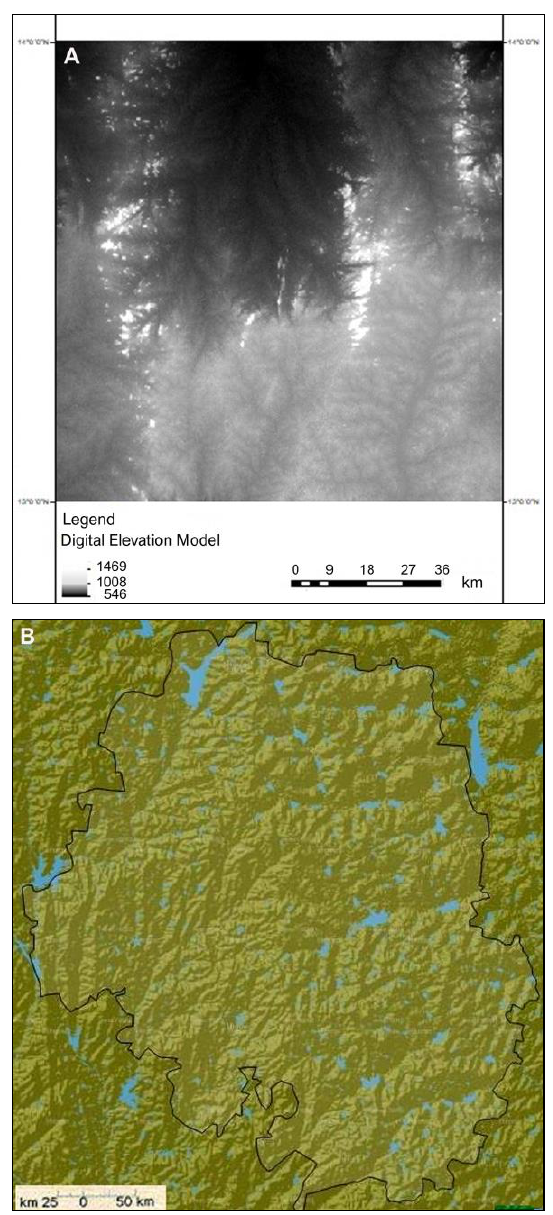
Fig. 3. Digital elevation model (A) and water bodies present in the study area